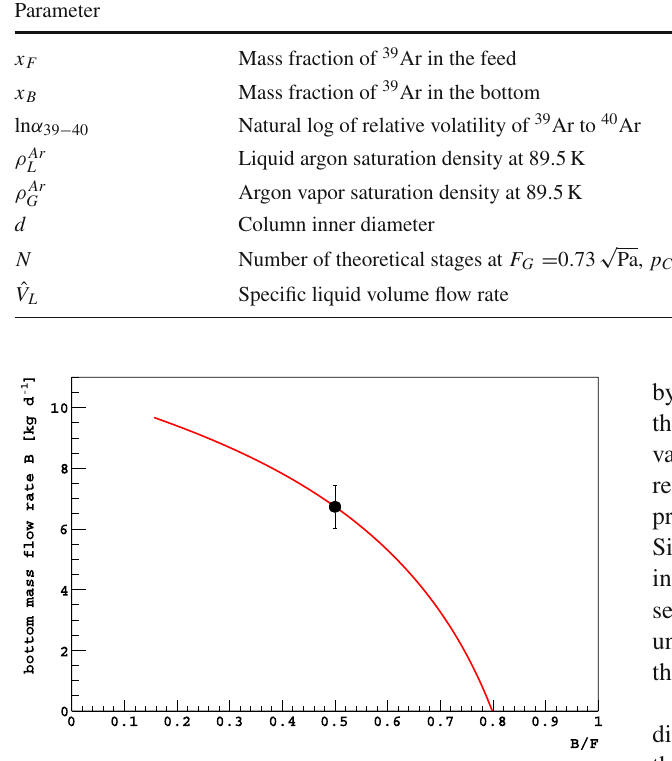
Fig. 19 39 Ar– 40 Ar distillation with the McCabe–Thiele method, with the input parameters of Table 2: B mass flow vs. B / F . The error bar at B / F = 0 . 5 represents the systematic uncertainty from ln α 39 − 40 . Other systematic uncertainties on this curve are discussed in the text and in Table 4 out to be at about 20 % height from the top of the